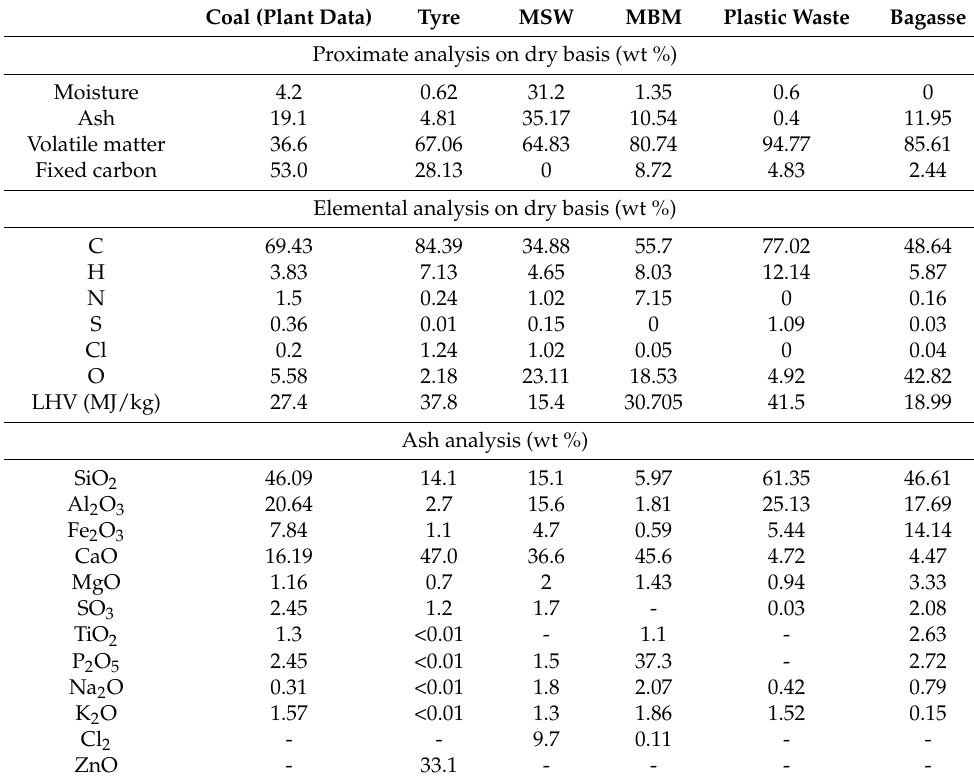
Table 3. Chemical composition and elemental analysis of fuels